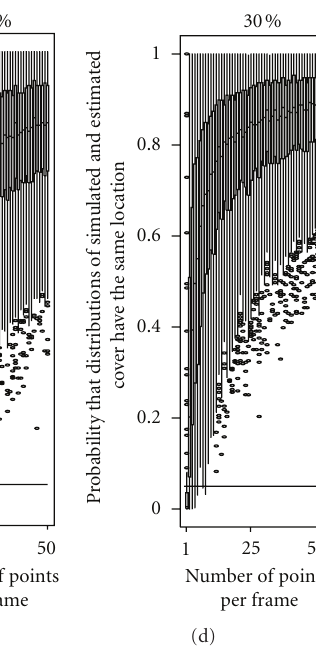
Figure 3: Box-and-whisker plots of P values resulting from the comparison of true ( μ between 5 and 30%; σ = μ ) and estimated benthic cover (1 to 50 points per frame), based on 500 replicate simulations. The P value ( y -axis) represents the probability that the distributions of estimated and true percent cover have the same location (Wilcoxon test). Horizontal line: statistical significance level ( α = 0 . 05). Above this line are plotted simulations for which there was not a statistically significant di ff erence between true and estimated cover distributions. Below it, there was a significant di ff erence between true and estimated cover, based on the Wilcoxon test.